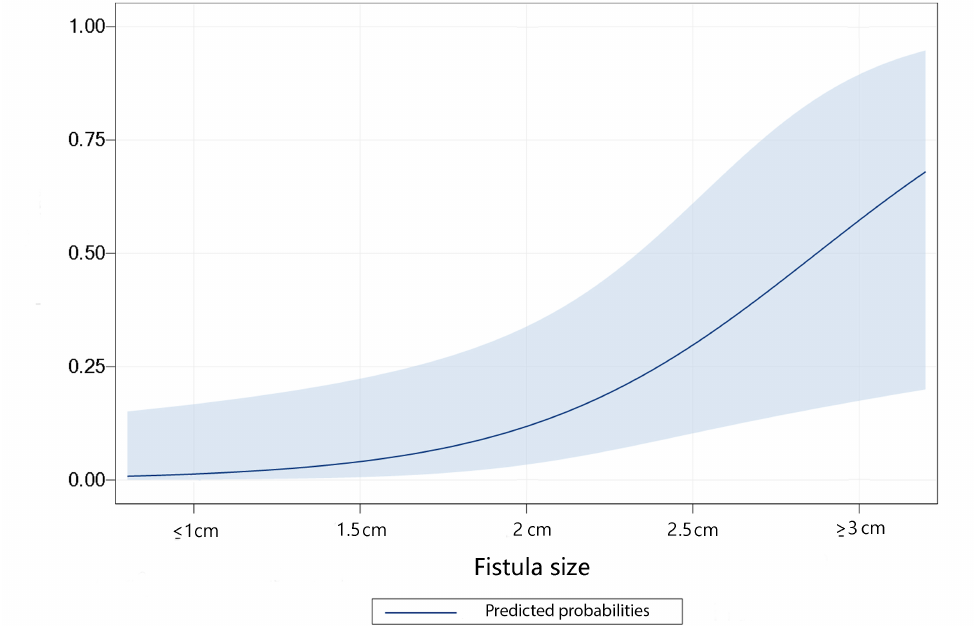
Figure 1 - Predicted probabilities for failure to repair urorectal fistula, according to fistula size expressed in